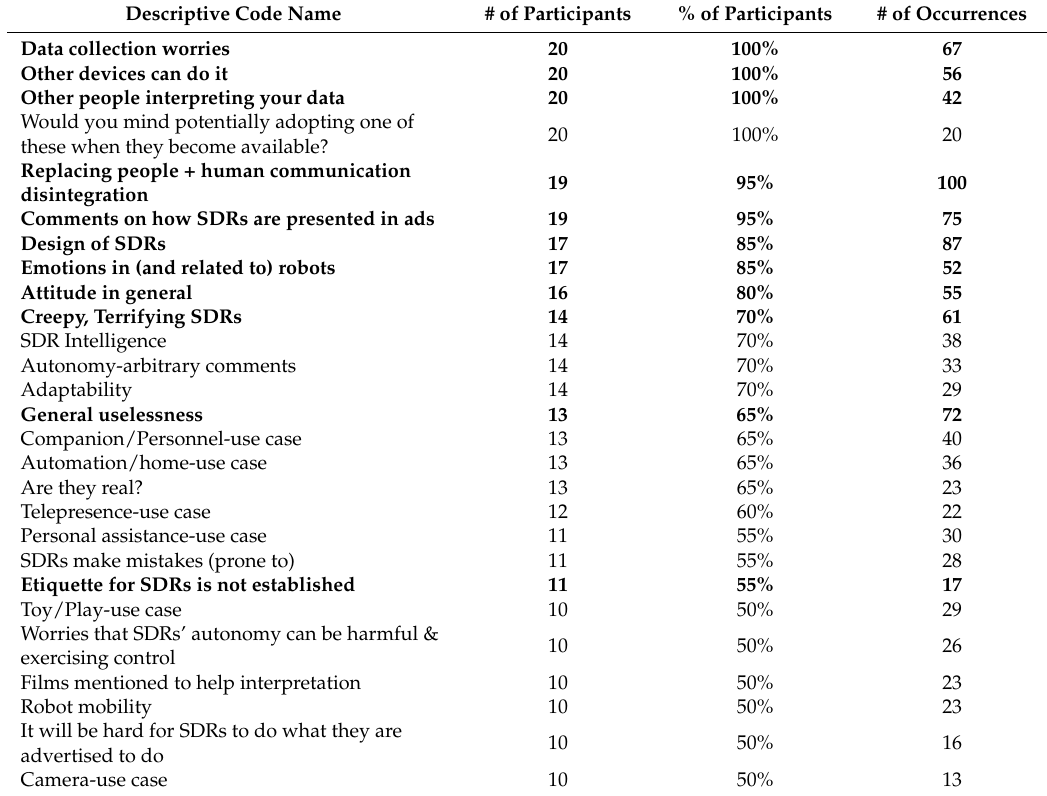
Table 1. Code names identified with at least half the participants, the number of participants identified with that code, the % of participants identified with that code, and the number of occurrences of the code. Ordered by # of participants. Codes included in the results and discussion below are